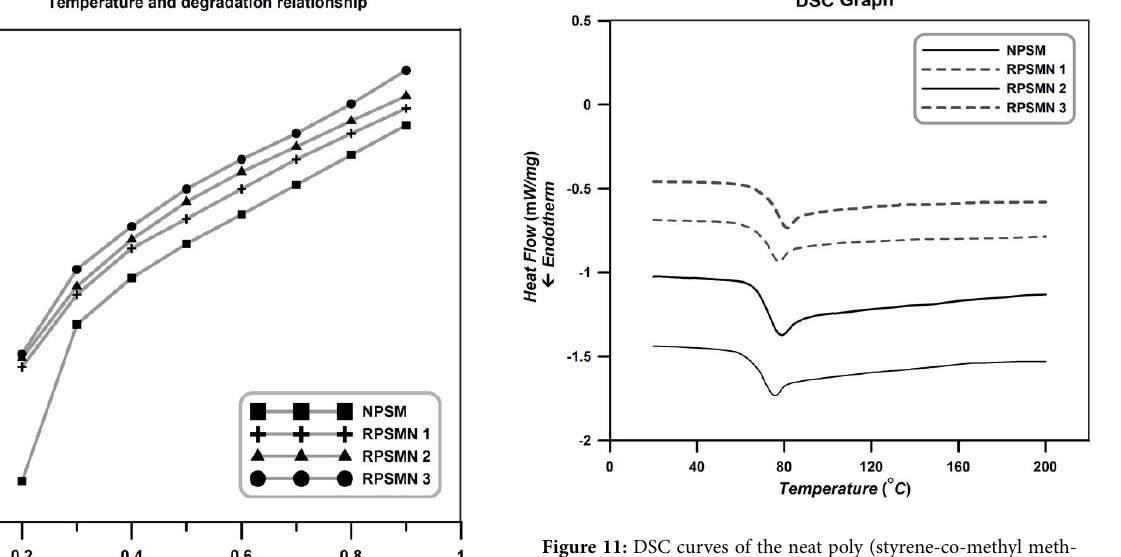
Figure 11: DSC curves of the neat poly (styrene-co-methyl meth- acrylate) and its